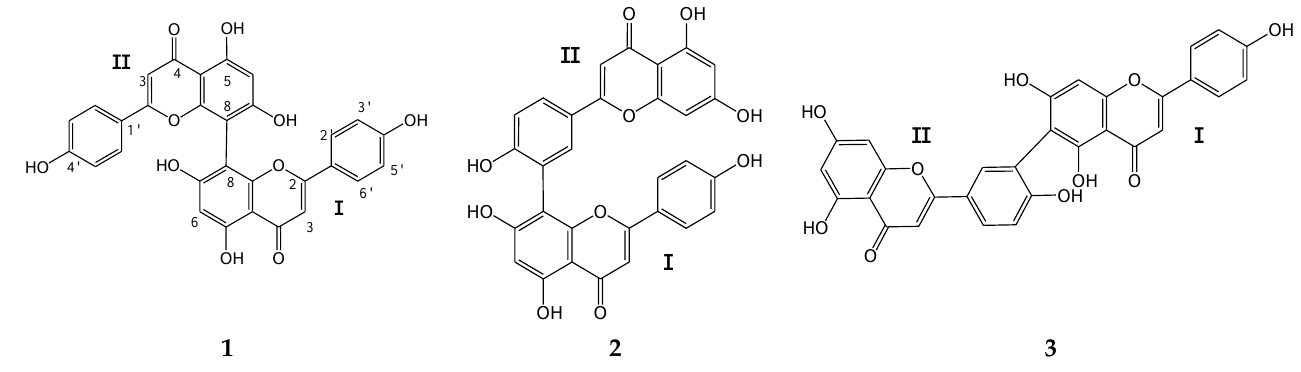
Figure 1. Chemical structure of the isolated biflavones.